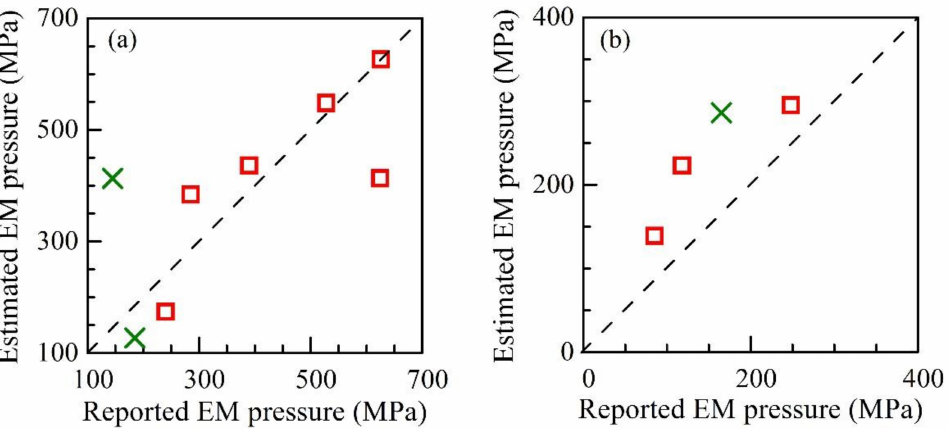
Figure 3. Analytically calculated and the corresponding reported values of the EM pressure (p) for MPW of ( a ) tubes and ( b ) sheets. The square and cross symbols indicate that the corresponding value(s) from the literature are computed numerically and analytically. Details of the process con- ditions and coil geometry details are provided in Tables 5 and 6 for tubes and sheets, respectively. Numerically computed results are taken from references [2,7,9–11,13,33,58]. Analytically computed results are taken from references